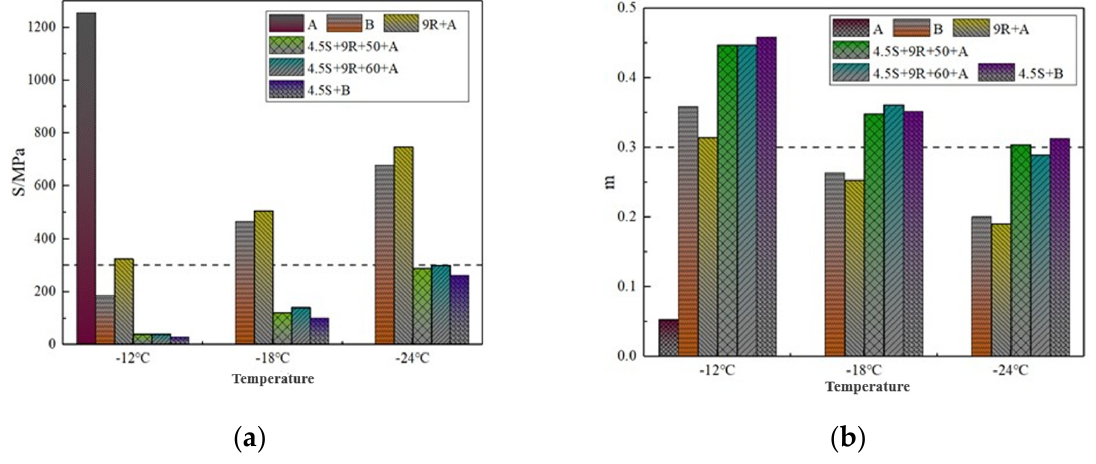
Figure 5. BBR test results of each asphalt at different temperatures: ( a ) Modulus of rigidity; ( b ) Creep rate.